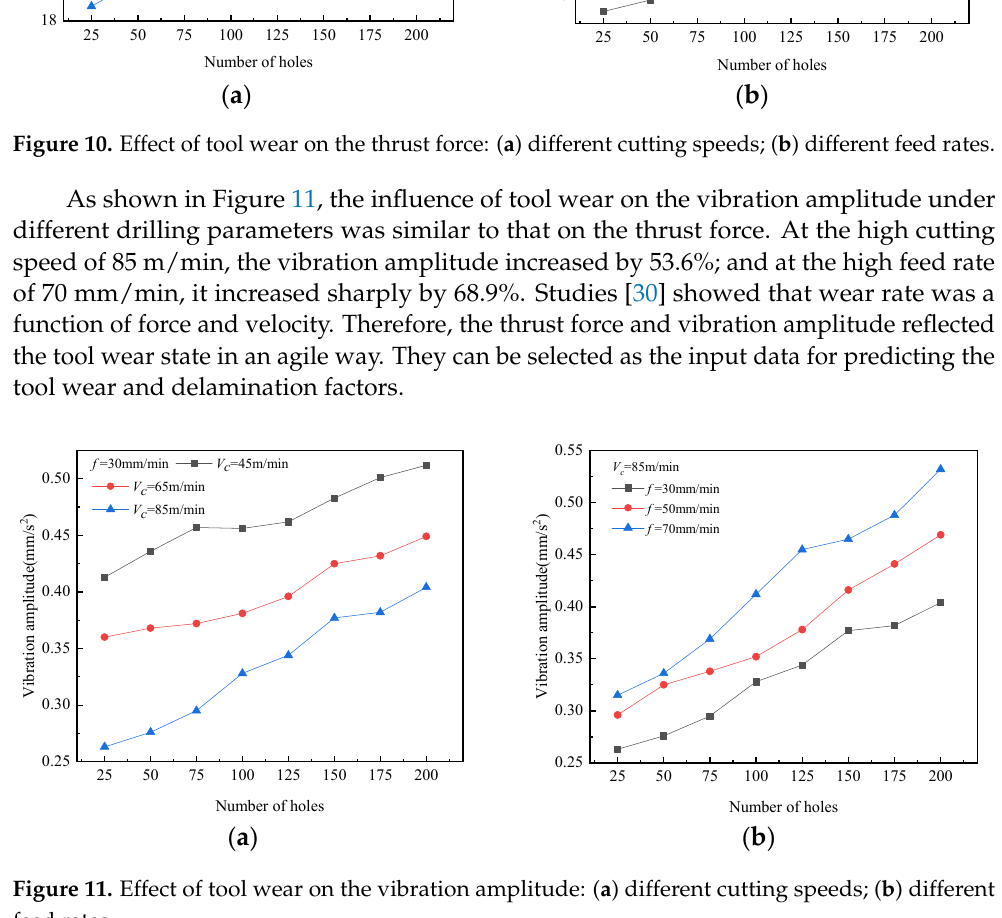
( b ) Figure 12. Effect of tool wear on the delamination factors: ( a ) entrance delamination factors; ( b ) exit delamination factors. According to the wear mechanism diagram established by Sathish Rao Udupi [31], the wear rate gradually increased with increasing spindle speed and feed rate. It was found that the increase in spindle speed and feed rate within the different stages of wear not only led to changes in the tool wear mechanism, but also had a huge impact on the surface quality and delamination factors. Furthermore, the increase in tool wear was not only related to the machining conditions, but also depended on the forces generated dur ‐ ing machining [17]. Combining the results of the analysis in Figures 9 and 11, the delami ‐ nation factor with the axial force should be selected as the input layer of the neural net ‐ work for the prediction of tool wear.